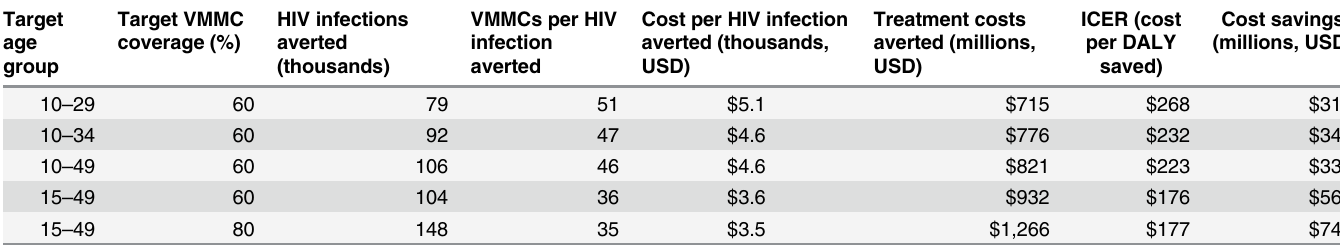
Table 1. Impact and cost of VMMC scale-up by target age group, 2015 – 2029.